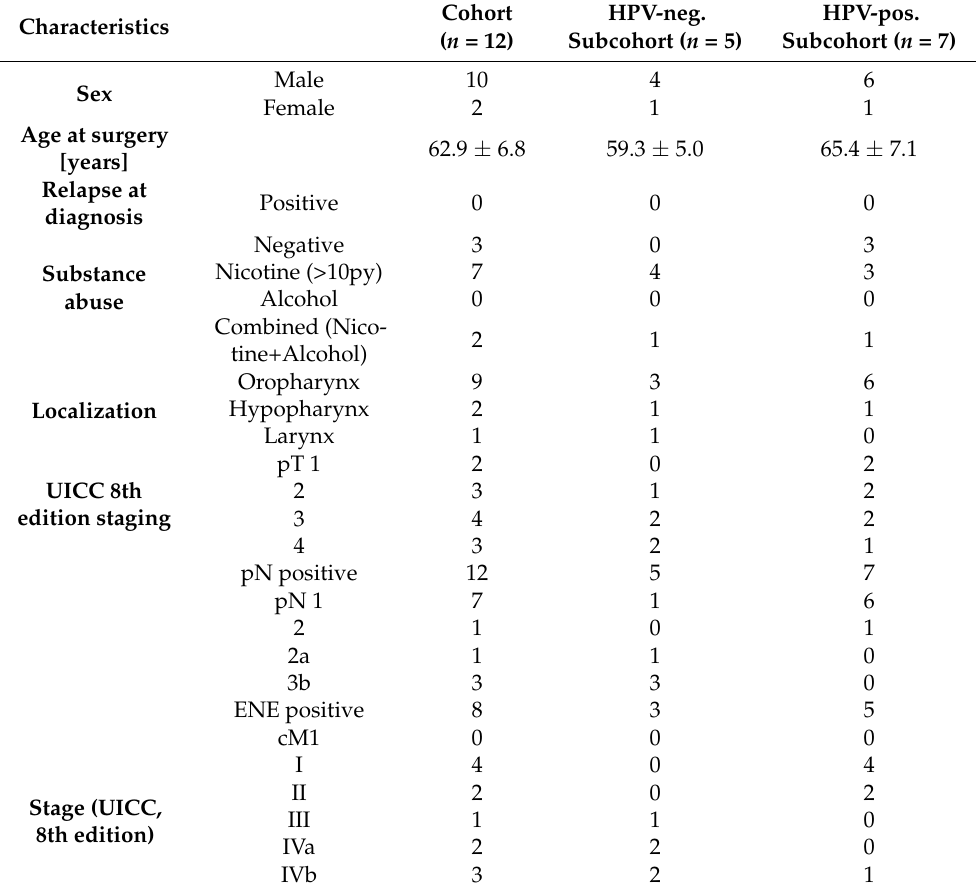
Table 1. General patient characteristics, risk factors, and disease stage of the surgical cohort. All continuous data variables are displayed as mean ± SD. HPV status is based on p16-immunostaining.